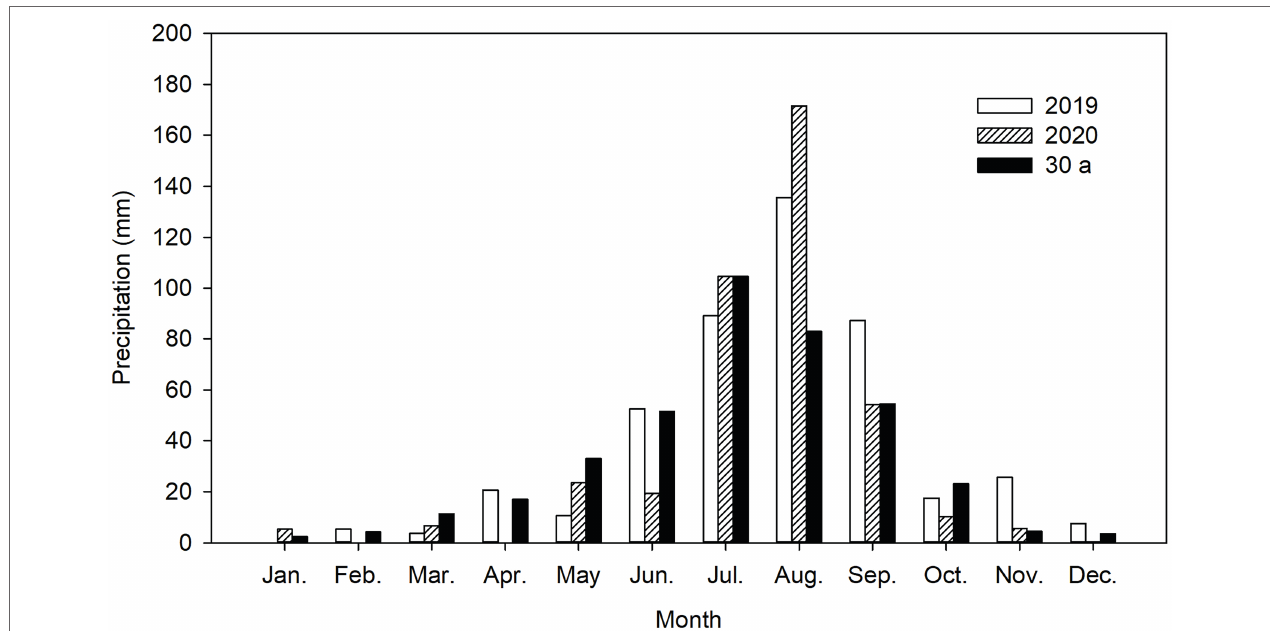
FIGURE 1 | Precipitation distribution from 2019 to 2020 and 30-year average (30 a) at the experimental